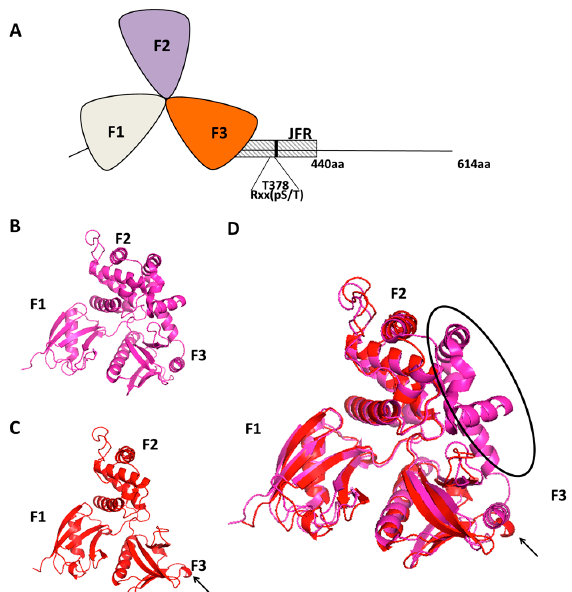
Figure 1. ( A ) A schematic representation of the N ‐ terminal clover leaf shaped FERM domain of Willin (containing the F1, F2 and F3 lobes 30–330 aa) and a JFR (juxta ‐ FERM domain region 330–440 aa) which contains a14 ‐ 3 ‐ 3 recognition consensus sequence (Rxx(pS/T)); ( B ) The Crystal structure of the FERM domain of Ezrin 4RM9; ( C ) The predicted crystal structure of the FERM domain of willin using Phyre 2; ( D ) The predicted three ‐ dimensional structure of the FERM domain of willin is superimposed over the crystal structure of the FERM domain of Ezrin 4RM9. The classical cloverleaf structure can be seen in the predicted FERM domain of willin. Black arrow points to an additional β‐ sheet on the F3 lobe of willin’s FERM domain. Black elliptical region highlights the extra α‐ helices that extend from the F3 lobe to shield the F2 lobe of ezrin.